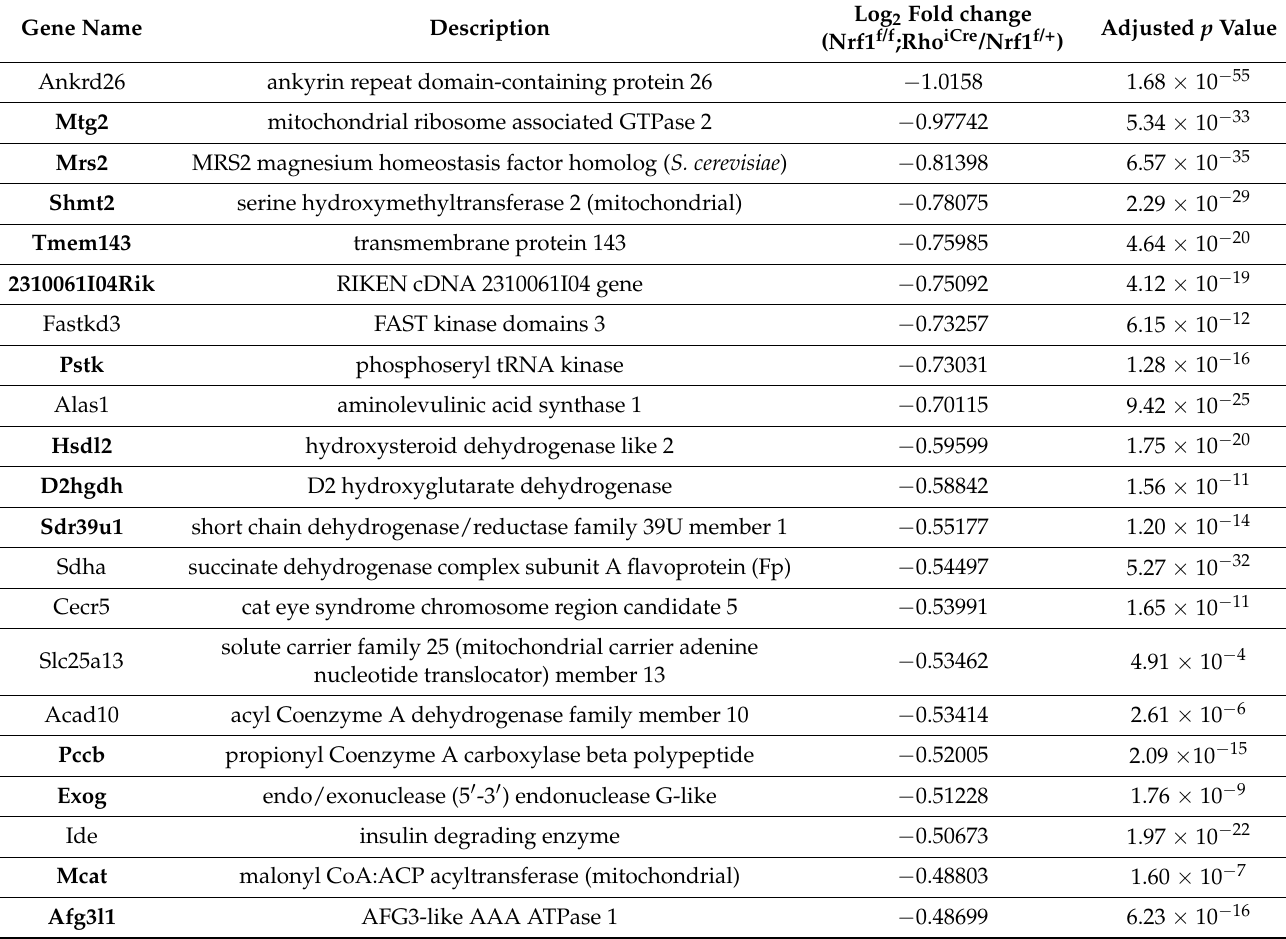
Table 2. Mitochondrial genes with modest changed expression levels in Nrf1 f/f ; Rho iCre retina.